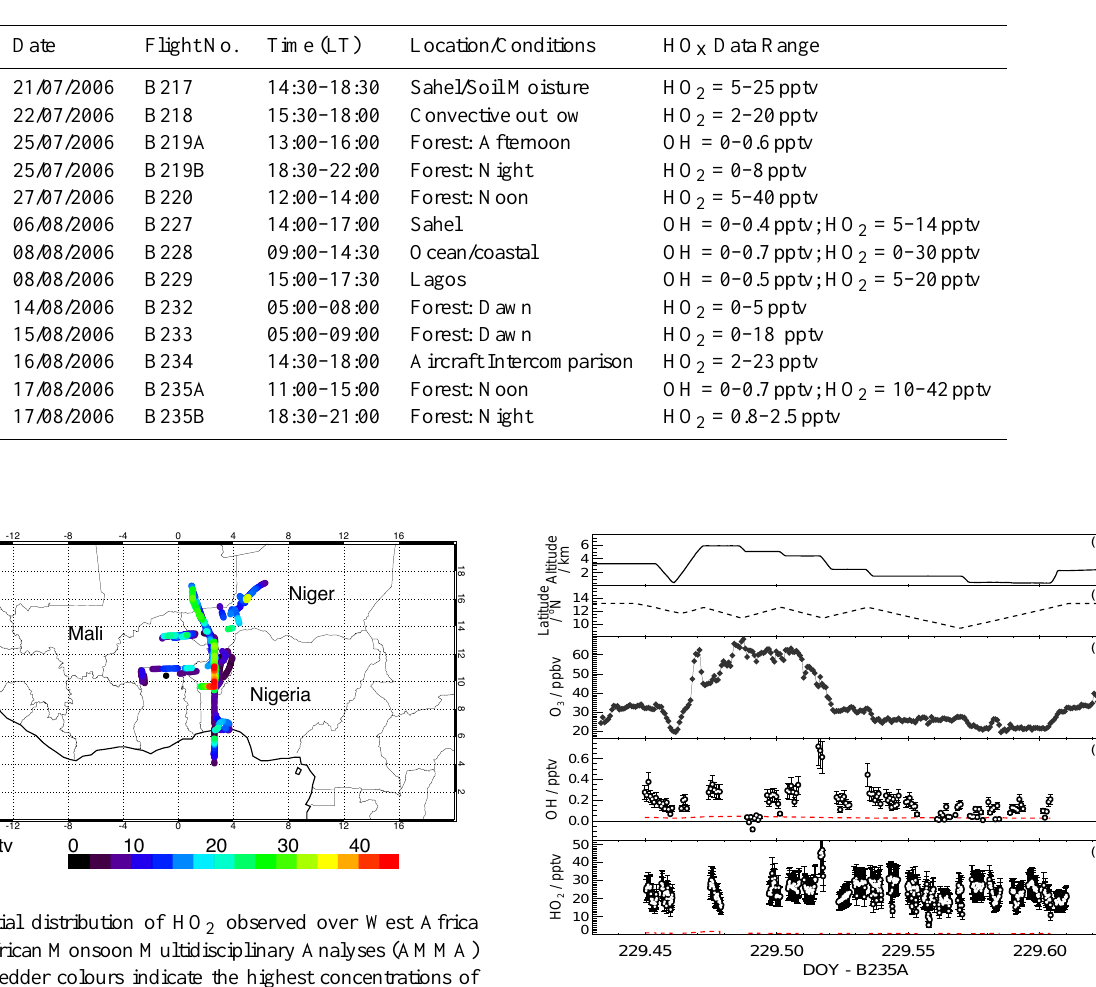
Table 2. Overview of HOx observations during AMMA flights. Flights were conducted at various times of day and over a range of terrain from Sahel to the north to heavily forested regions to the south, as well as over the Gulf of Guinea to the far south